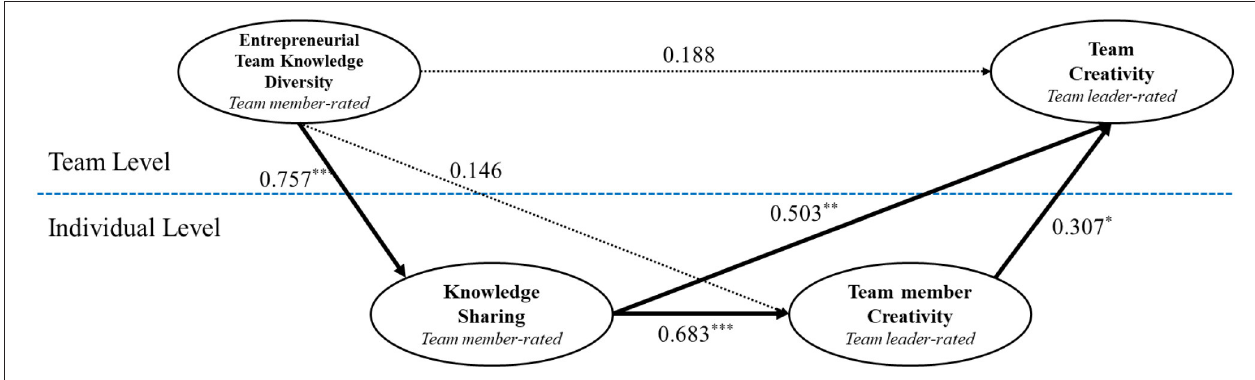
FIGURE 2 | Results of multilevel sequential mediation analysis. * p < 0.05, ** p < 0.01, *** p < 0.01; Unstandardized coefficients are presented.